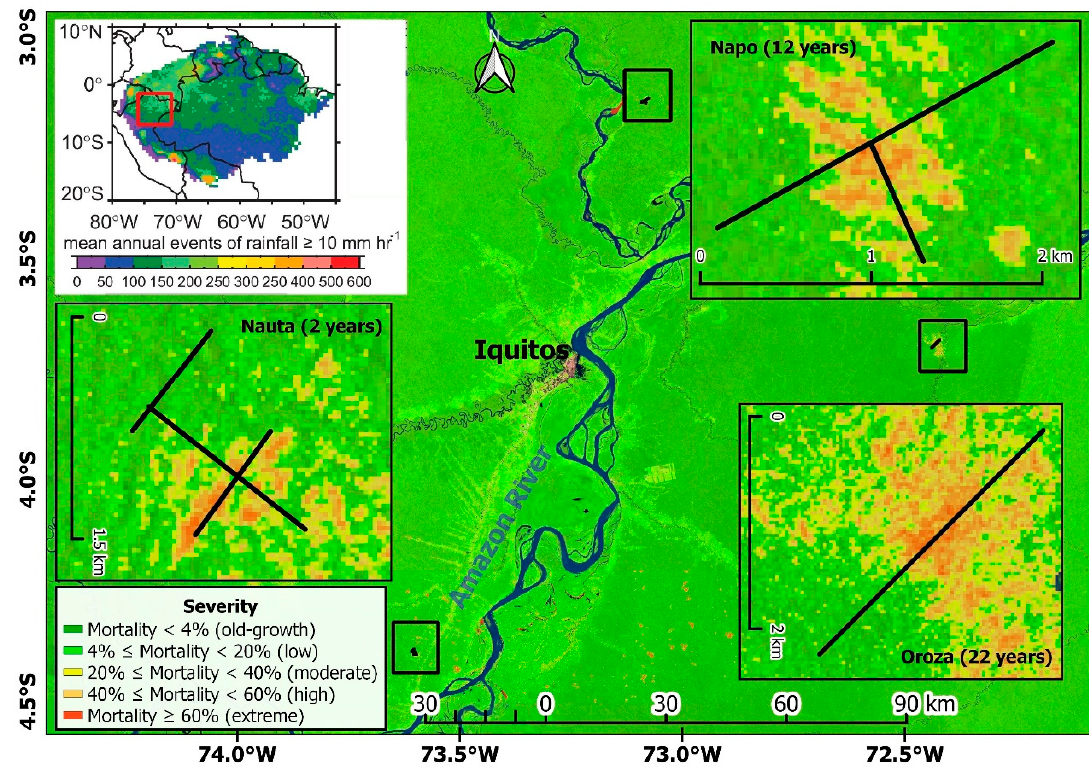
Figure 1 . Top left inset: Map demonstrating the mean annual number of rainfall events for the period 1998–2016 obtained using TRMM. The red square indicates the location of the study sites near Iquitos, Perú. Main figure: Map of windthrow severity over the study region. Small black squares indicate the locations of the Nauta, Napo, and Oroza sites (3 ha each). These sites are enlarged in the top right, bottom right, and bottom left inset panels which include transects (black lines) located across the windthrow gradient within each field site.